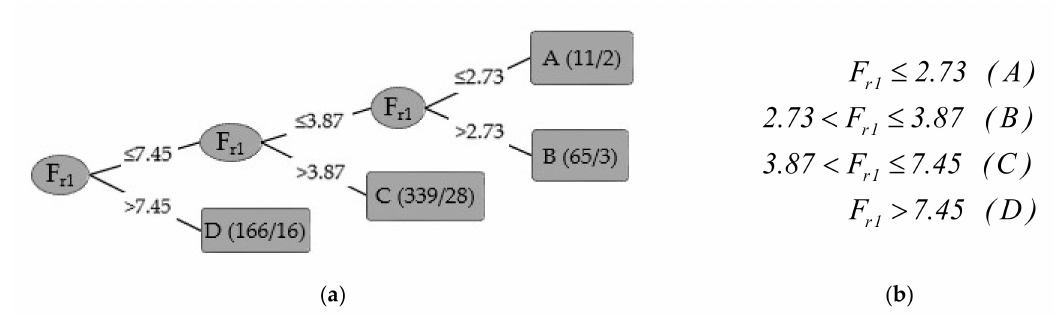
Figure 4. Decision tree and classification chart of the hydraulic jump with all rough bed: ( a ) Decision tree classifier model (the numbers in brackets (e.g., 11 / 2 for class A) stands for the total number of data (e.g., 11) and the false classifications (e.g., 2) falling in each class, respectively). ( b ) Classification